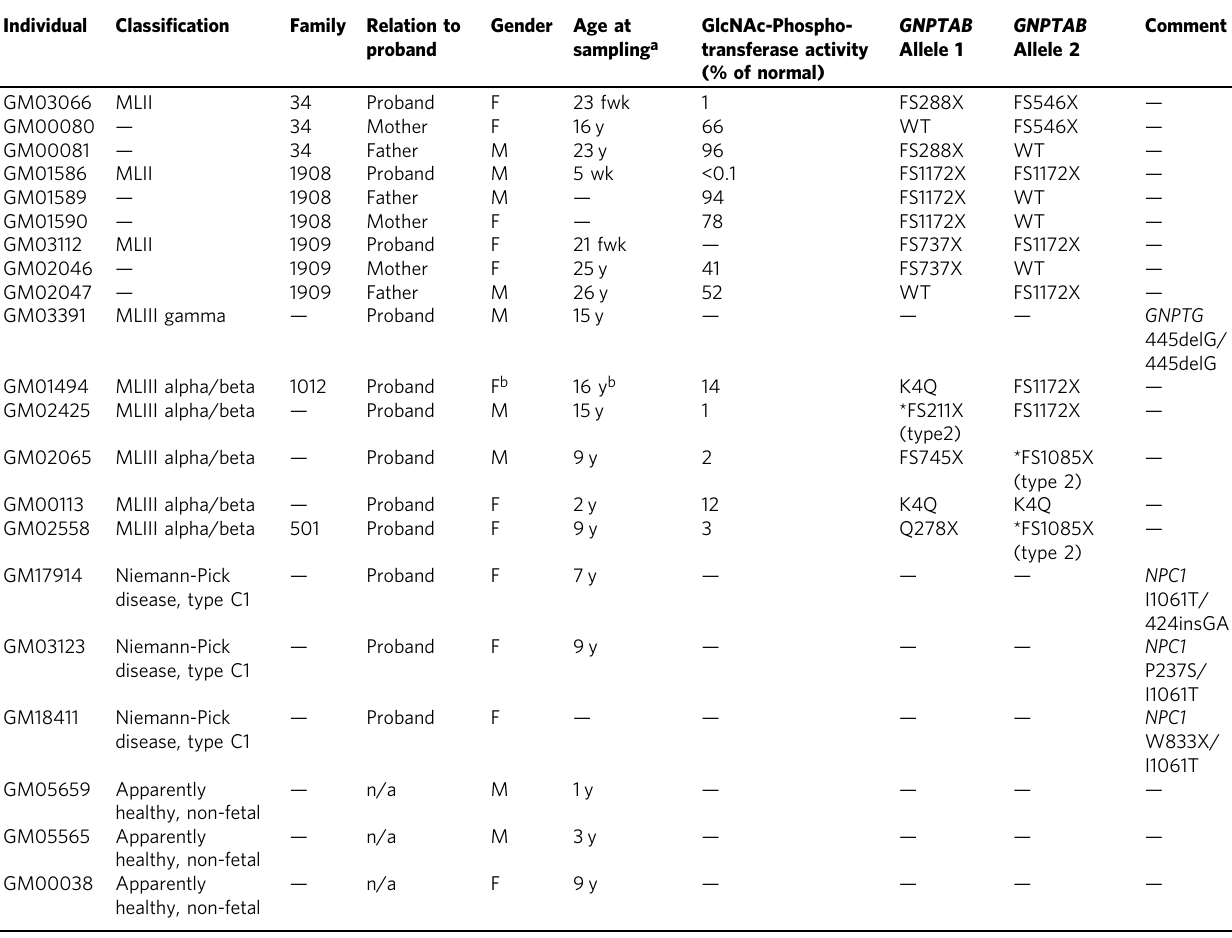
Table 3 Primary human fi broblast cells used in this study